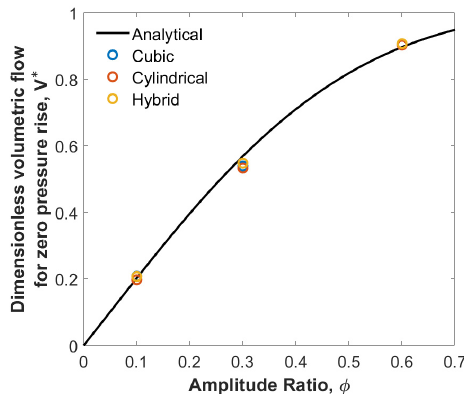
Figure 12. Volumetric flow rate history during the ramp time for different initial particle arrange- ments. Table 2. Effect of particle arrangement in the SPH simulations.